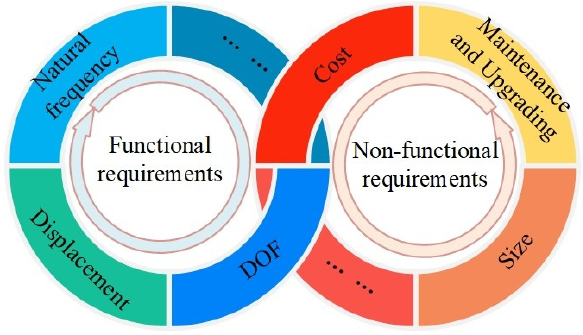
Figure 1. Performance requirements for an MPS.